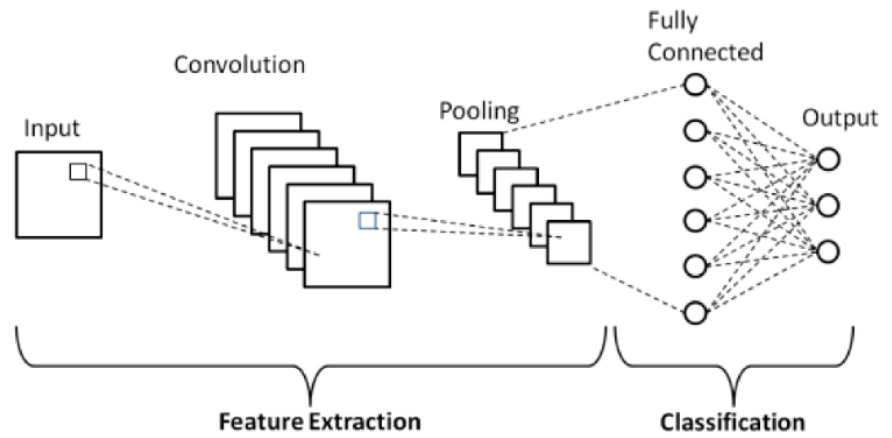
Figure 6. DenseNet121 architecture [22]